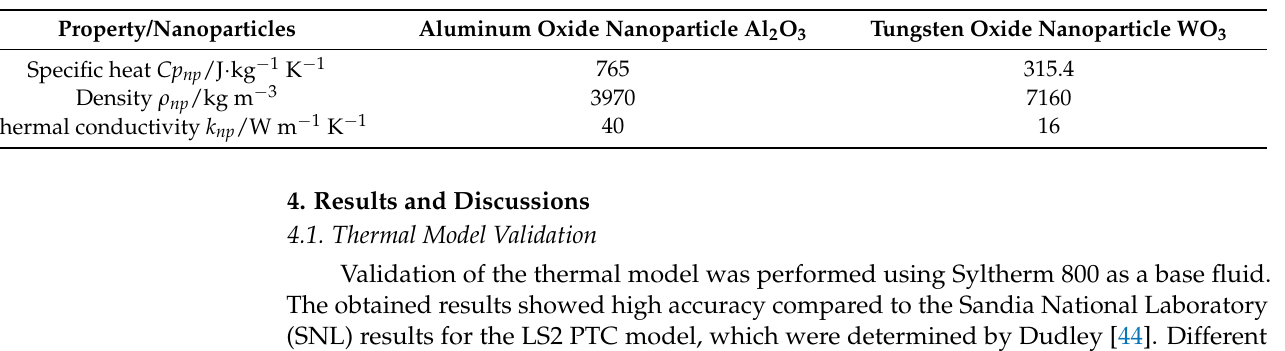
Table 5. Nanoparticle thermal properties [42,46].